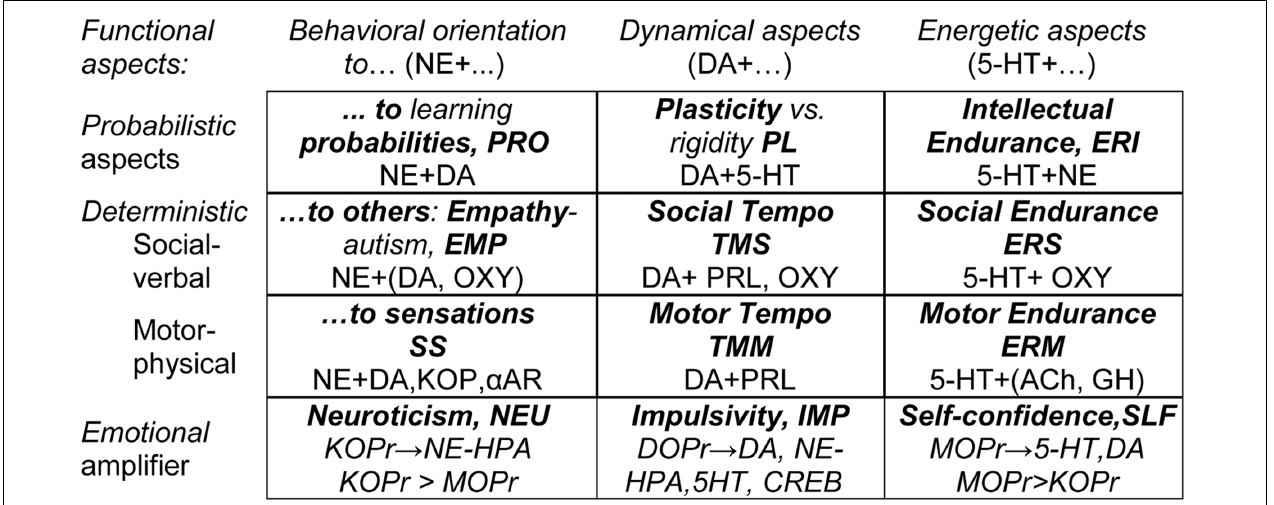
FIGURE 1 | The neurochemical model Functional Ensemble of Temperament (FET): 12 traits regulate specific functional aspects of behavior and are based on interacting neurotransmitter systems. Bold font highlights names of the temperament traits and their abbreviations. 5-HT, serotonin; DA, dopamine; NE, norepinephrine; Ach, acetylcholine; GH, Growth Hormone; SOM, Somatostatin; PRL, prolactin; OXY, oxytocin; α AR – α -adrenoceptors, KOPr, MOPr, DOPr, κ -, µ -, and (cid:49) -opioid receptor